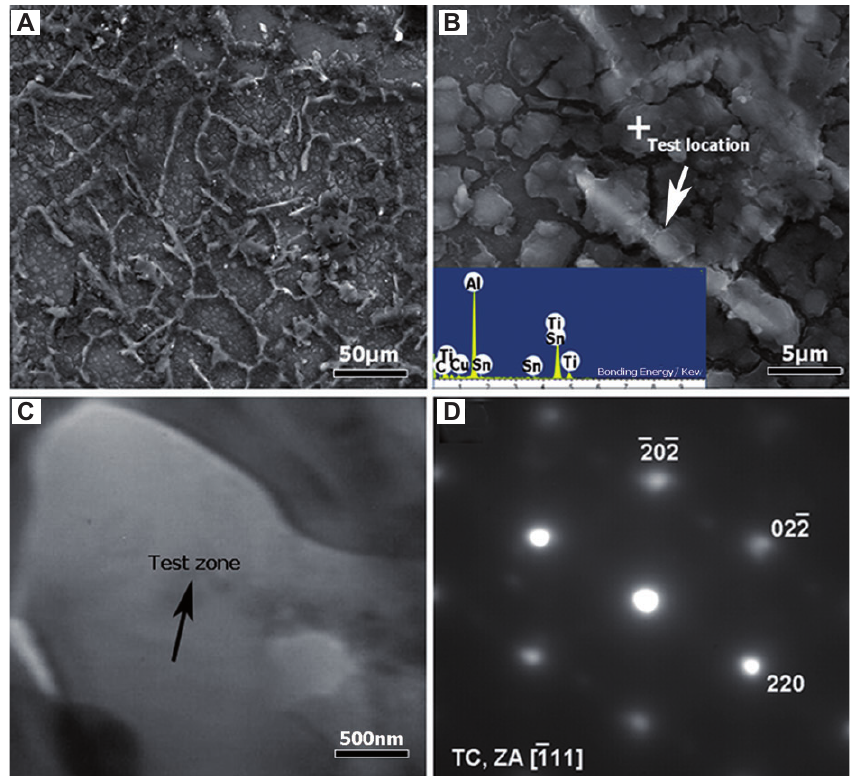
Figure 2 SEM micrographs of the composite coating. (A) Upper coating, (B) fine particles/EDS result, (C) TEM morphology of TiC, (D) electron diffraction pattern.